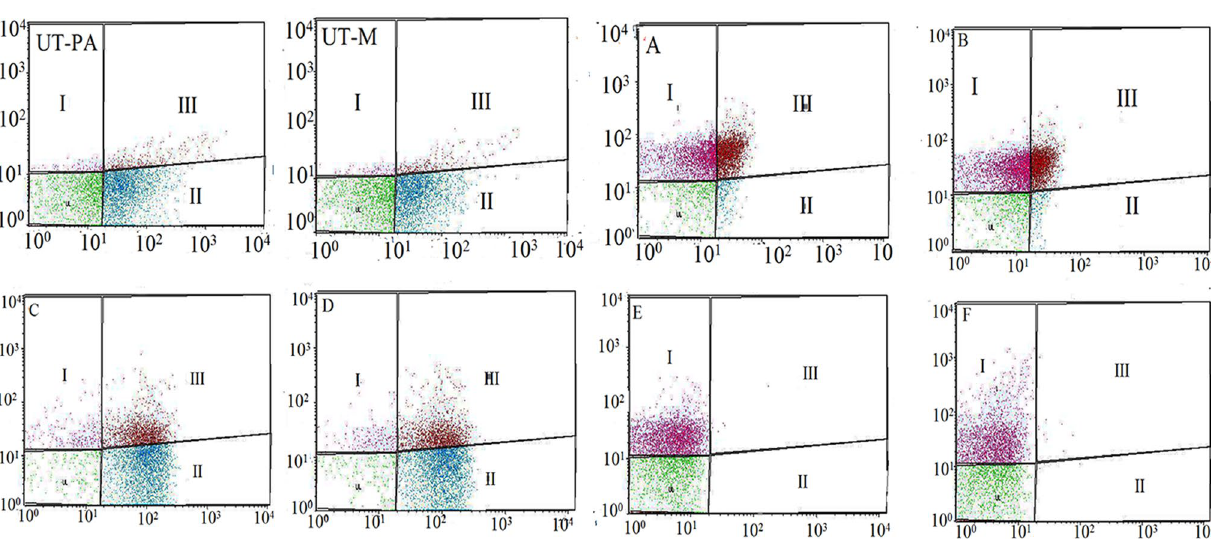
Figure 10. Membrane integrity assessment by live/dead staining of P. aeruginosa and MRSA cells by flow cytometer. Flow cytometer scatters plot for (UT-PA) untreated P. aeruginosa cells, (UT-M) untreated MRSA cells ( A ) LP treated P. aeruginosa cells stained with SYTO9/PI stains were analyzed, ( B ) LP treated MRSA cells stained with SYTO9/PI stain, ( C ) Cu-NPs treated P. aeruginosa cells stained with SYTO9/PI, ( D ) Cu-NPs treated MRSA cells stained with SYTO9/PI, ( E ) EL-LP-CuNPs treated P. aeruginosa cells stained with SYTO9/ PI, ( F ) EL-LP-CuNPs treated MRSA